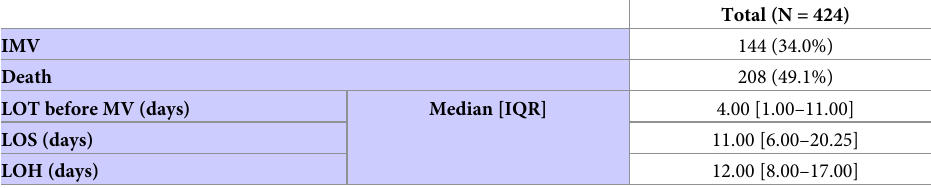
Table 1. Outcomes of COVID-19 patients admitted to ICU.